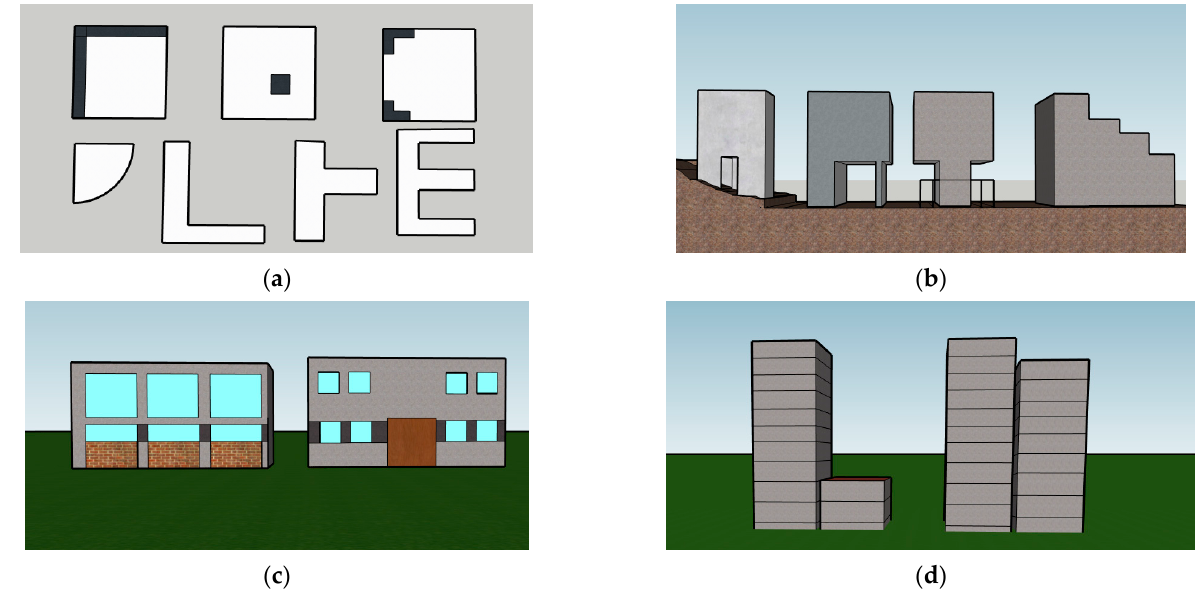
Figure 2. Recurrent pathologies in buildings. ( a ) Horizontal irregularities, ( b )Vertical irregularities, ( c ) Short columns and ( d ) Risk of pounding between adjacent buildings.